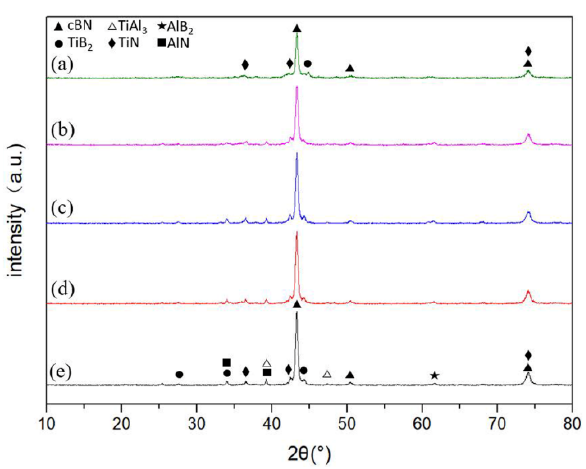
Figure 3. XRD spectra of sintered cBN composites: ( a ) 5 μ m, ( b ) 15 μ m, ( c )17 μ m, ( d ) 26 μ m, ( e ) 29 μ m.